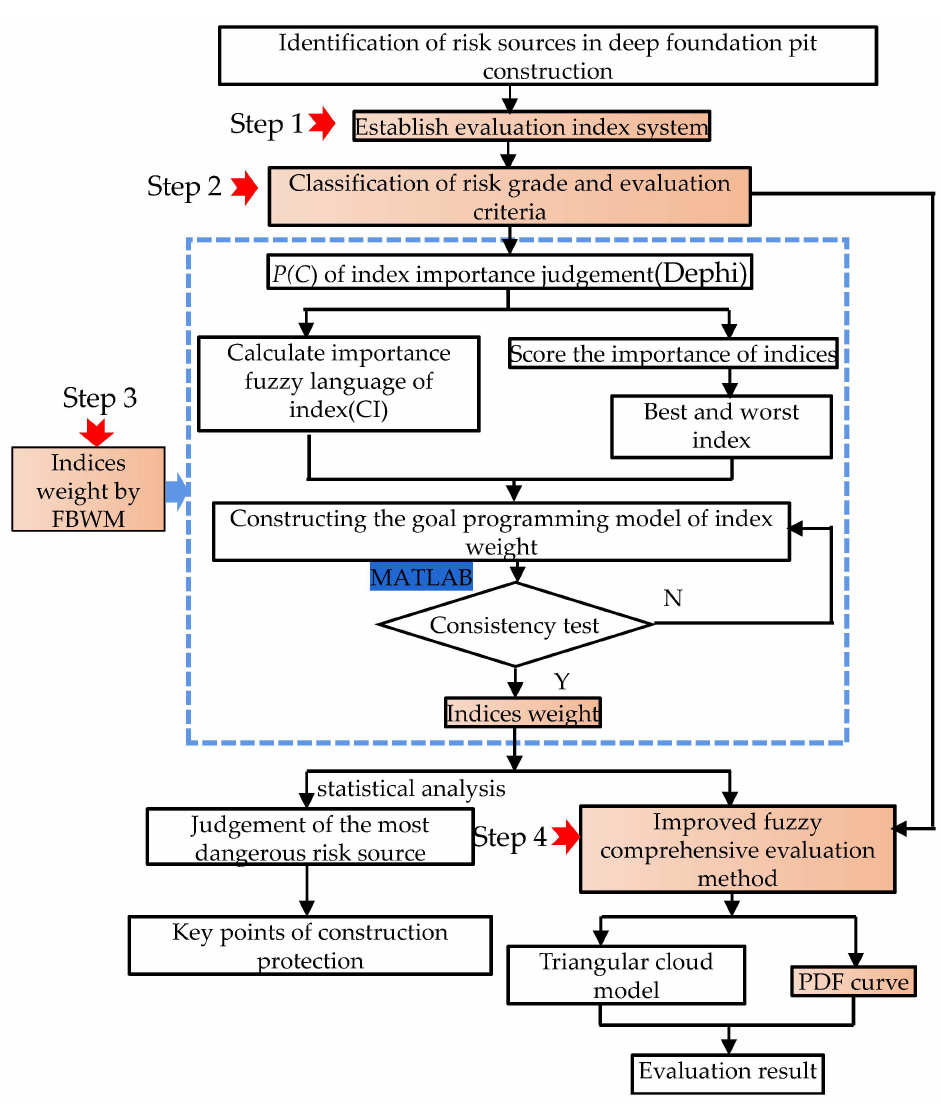
Figure 1. Risk evaluation process of deep foundation pit